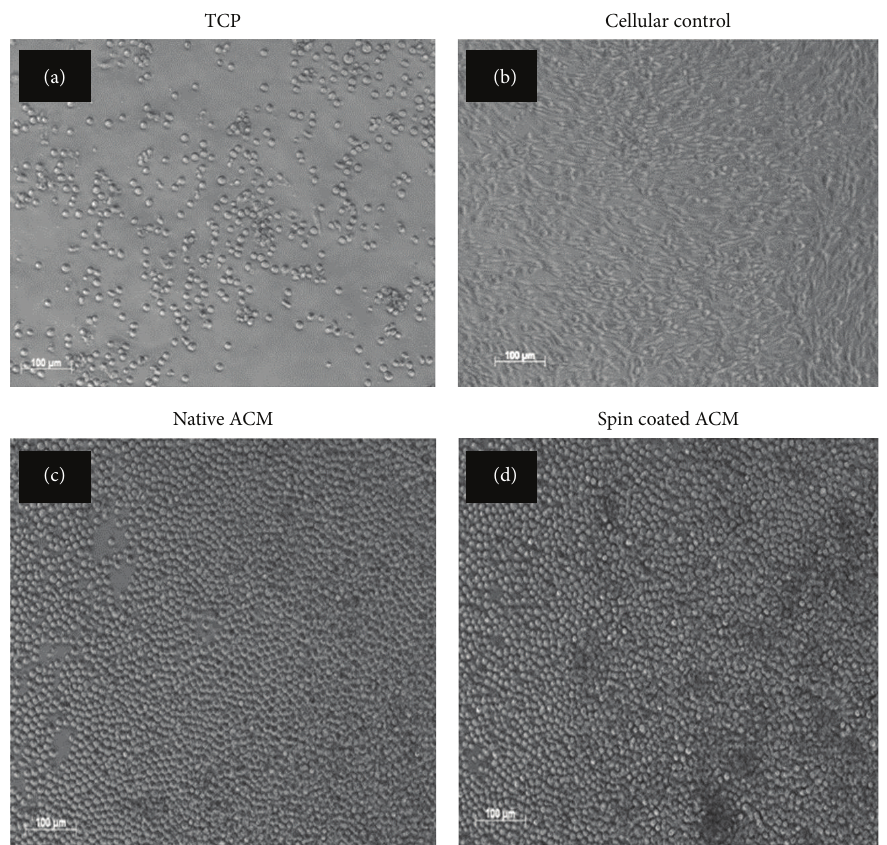
Figure 8: UCB HSPC expansion on various ACM and control surfaces. (a) TCP— no matrix. (b) Cellular control ( stromal cells ). (c) Native HS-5 ACM. (d) HS-5 spin coated